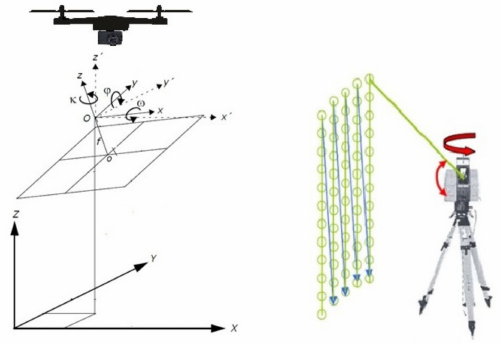
Figure 13. TLS-UAV registration